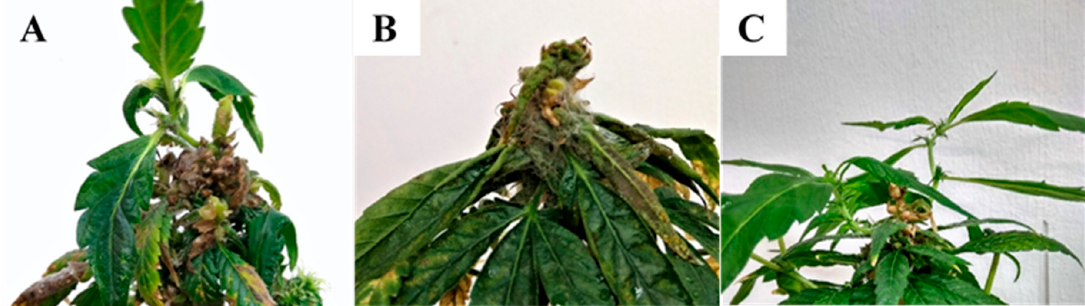
Figure 4. Koch postulate assays of intact MC plants sprayed with a 10 6 spores/ml spore suspension of ( A ) Alternaria alternata (isolate 22A), ( B ) Botrytis cinerea (isolate 63A), and ( C ) a control plant sprayed with sterile distilled H 2 O.